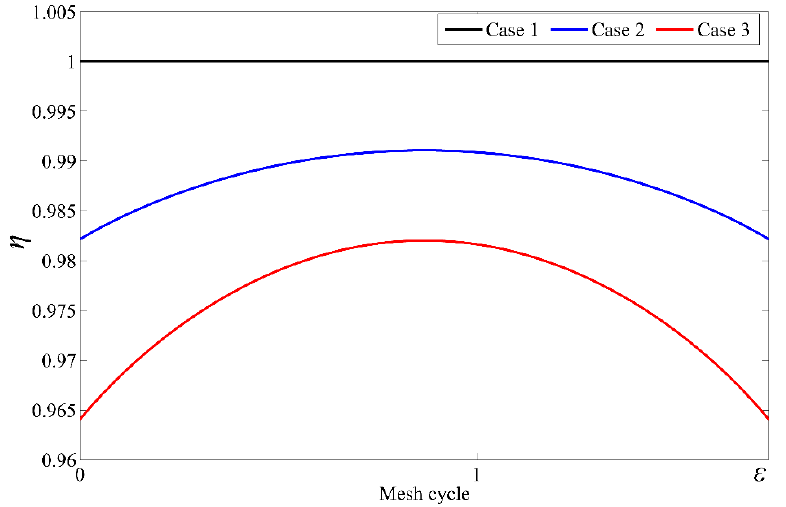
Figure 5. 𝜂 for the different values of backlash.